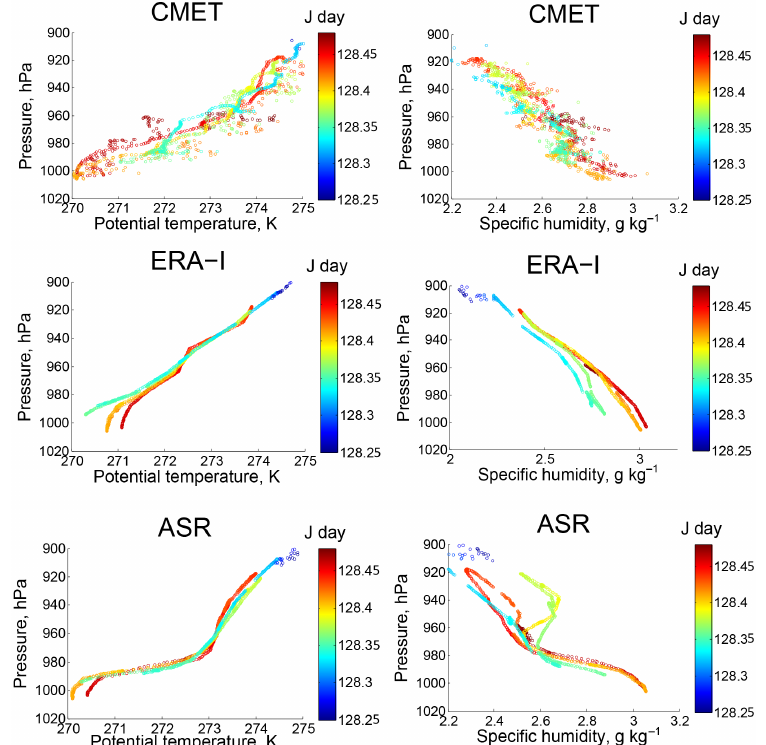
Figure 7. Profiles of potential temperature and specific humidity during flight 4 as observed by the CMET balloon and according to the 4-D interpolated ERA-I and ASR model